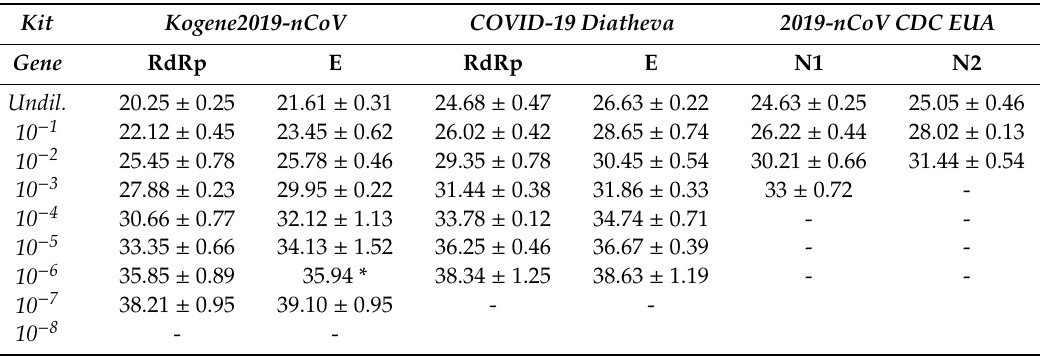
Table 1. Limits of detection using the positive controls provided by the manufacturer of three commercial kits. Results are presented as average cycle threshold ( C t ) of two independent experiments ± standard deviation (SD). Kogene2019-nCoV COVID-19